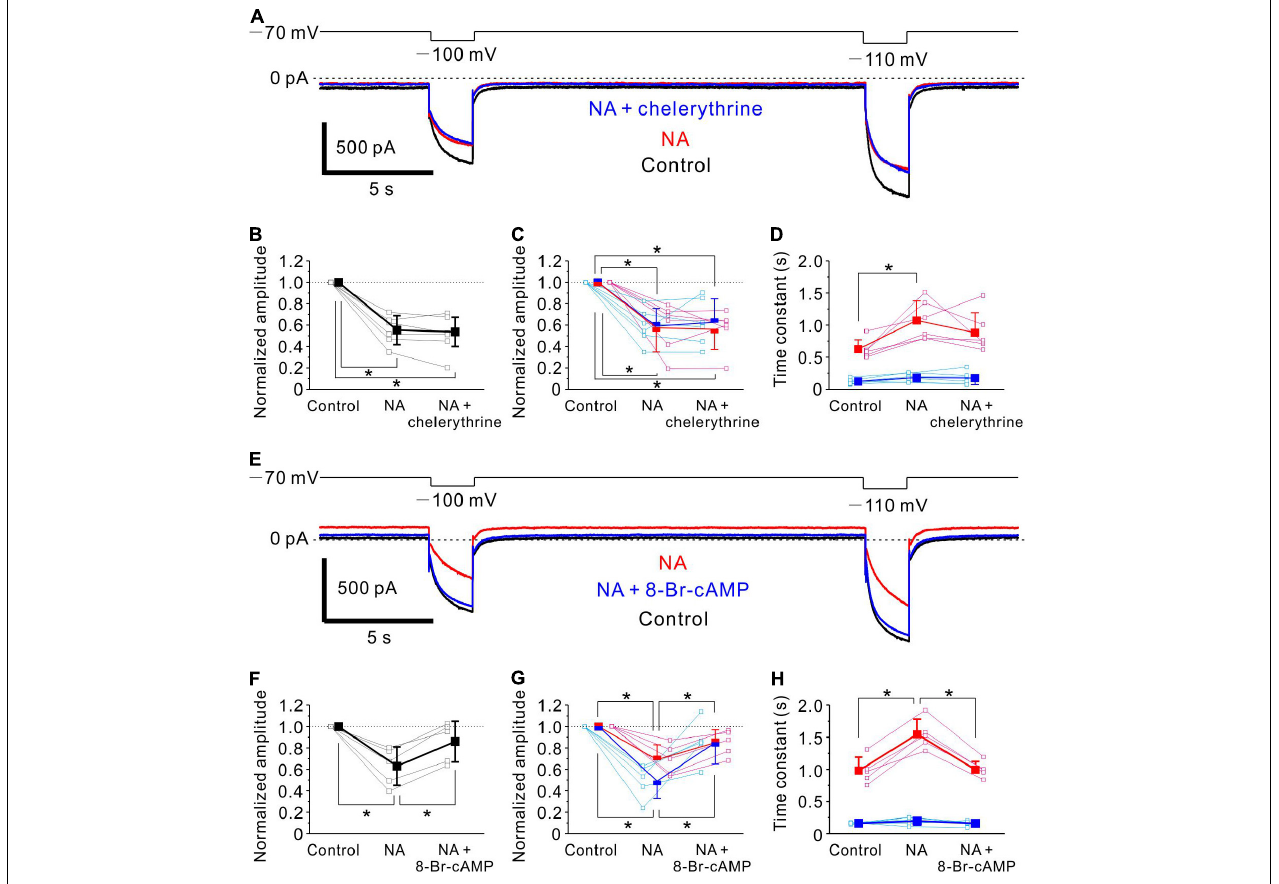
FIGURE 6 | Noradrenaline -induced Ih inhibition in MTN neurons is mediated by cAMP signaling. (A) Ih responses evoked by negative voltage pulses stepped from –70 to –100 mV and –110 mV in an MTN neuron obtained under control conditions (black), during application of NA (red) and during application of NA and chelerythrine (blue). Chelerythrine had no effect on NA-mediated Ih inhibition. (B) Normalized amplitude of Ih at respective conditions in (A) (control, 1.0; NA, 0.55 ± 0.14; NA + chelerythrine, 0.54 ± 0.14; n = 6). One-way repeated measures ANOVA: p < 0.001, followed by Bonferroni post hoc test, * p < 0.001 (control vs. NA), and * p < 0.001 (control vs. NA + chelerythrine). (C) Normalized amplitude of fast and slow components (blue and red squares, respectively) at respective conditions in (A) ( n = 6). Normalized amplitude of fast component: control, 1.0; NA, 0.59 ± 0.17; NA + chelerythrine, 0.63 ± 0.22. One-way repeated measures